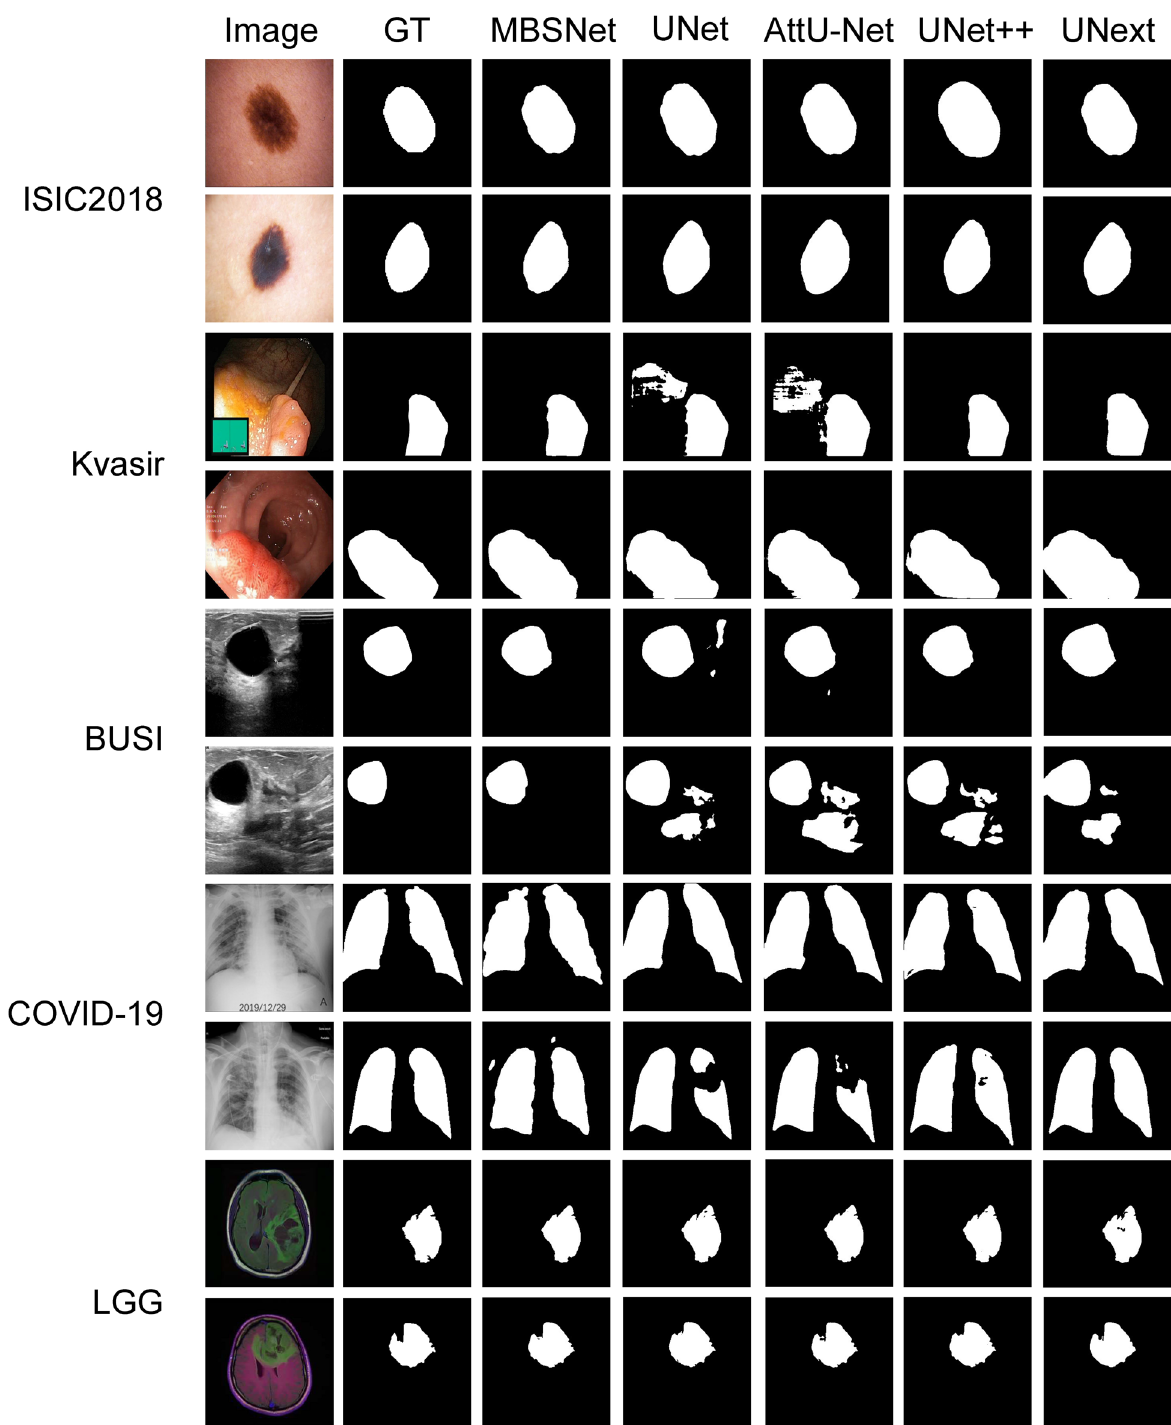
effectively suppress the misleading of error information to obtain accurate prediction